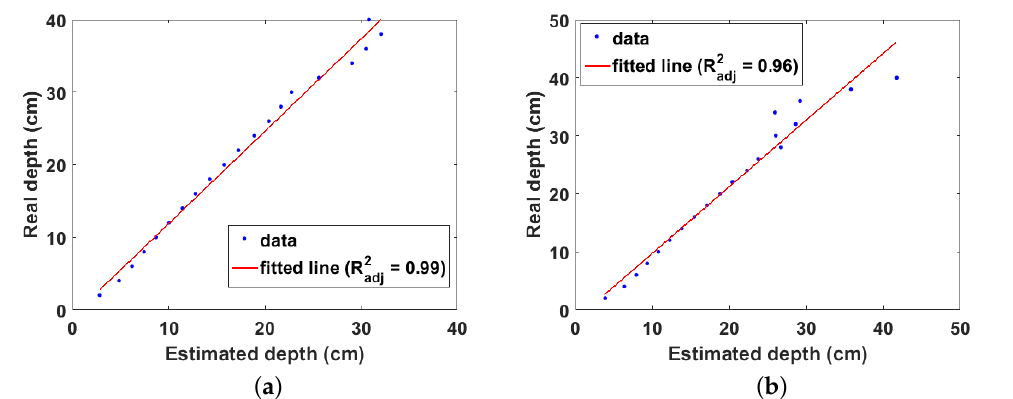
Figure 8. ( a ) Linear fit of estimated and real depth for Cs-137 buried in concrete of density = 2.18 g cm − 3 ; ( b ) linear fit of estimated and real depth for Cs-137 buried in concrete of density = 3.35 g cm − 3